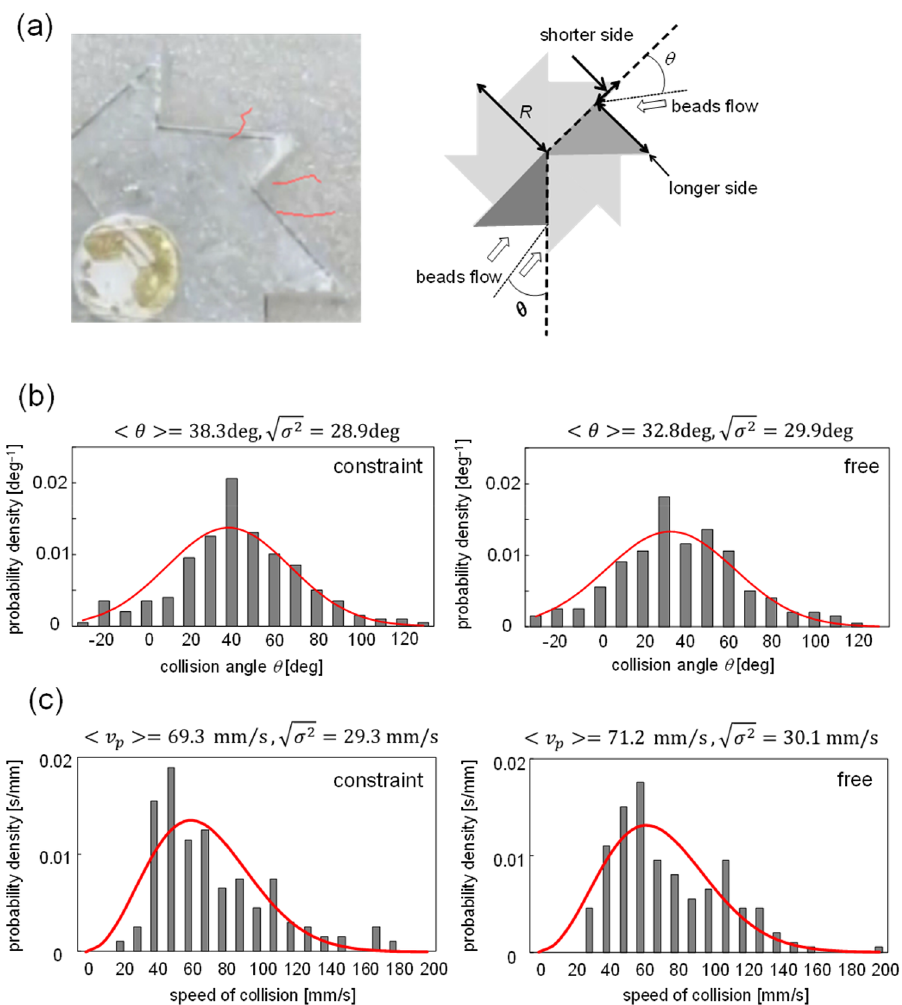
Figure 5. Characteristics of bead motion. ( a ) Examples of trajectory of beads with 0.6 mm diameter under 30 Hz, and definition of collision angle θ . ( b ) Distribution of collision angle. ( c ) Distribution of collision speed. Solid curve shows approximation by ( b ) normal and ( c ) Maxwell–Boltzmann distributions. Average and dispersion are shown at the